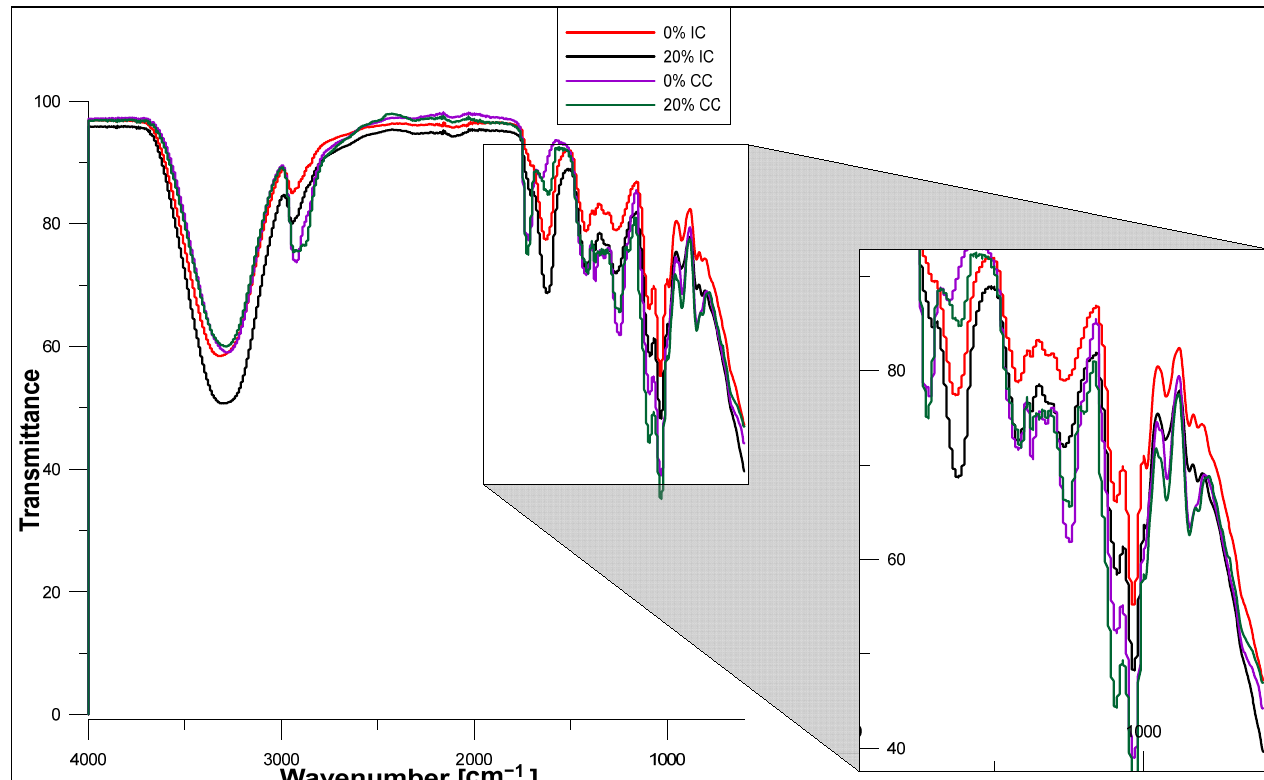
Figure 5. FT-IR spectra of SA/PVA hydrogels prepared using method I (ionic crosslinking, IC) or method II (chemical crosslinking, CC).